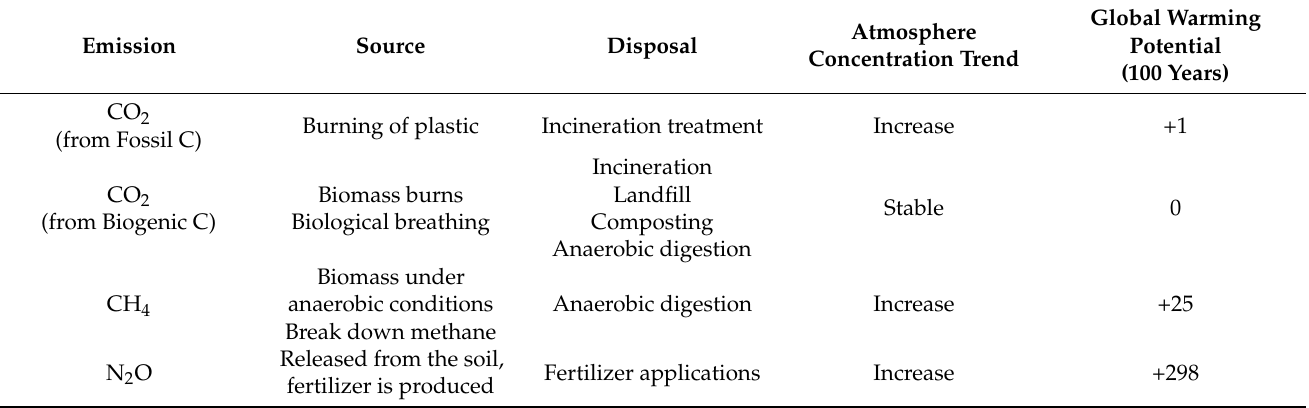
Table 2. Greenhouse gas emission factors for the waste